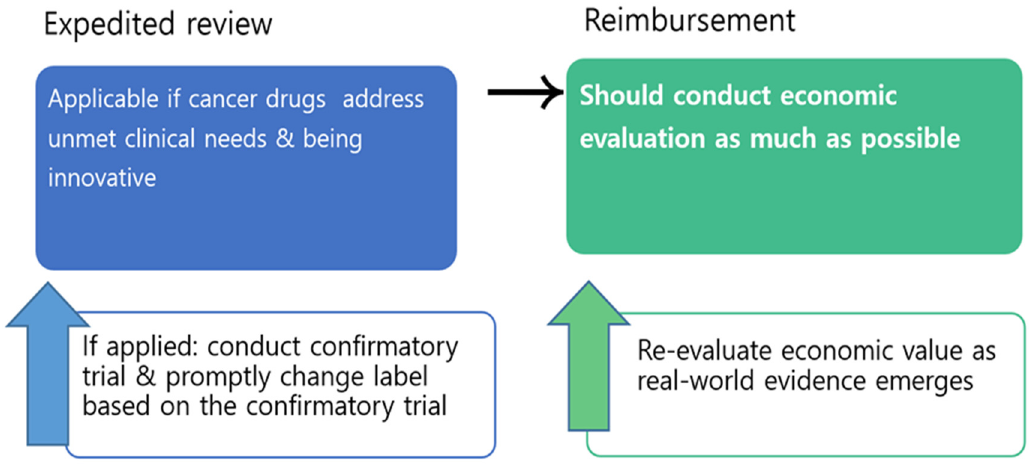
Figure 1. Market access process proposal for cancer drugs.